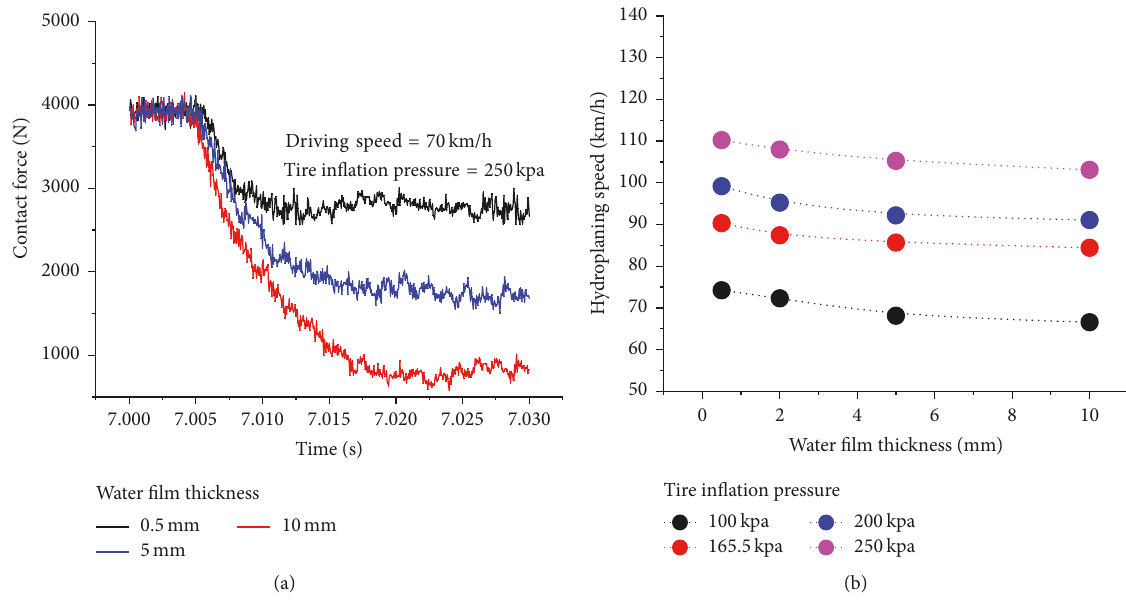
Figure 14: Contact force and hydroplaning speed influenced by water film thickness: (a) contact force; (b) hydroplaning speed.